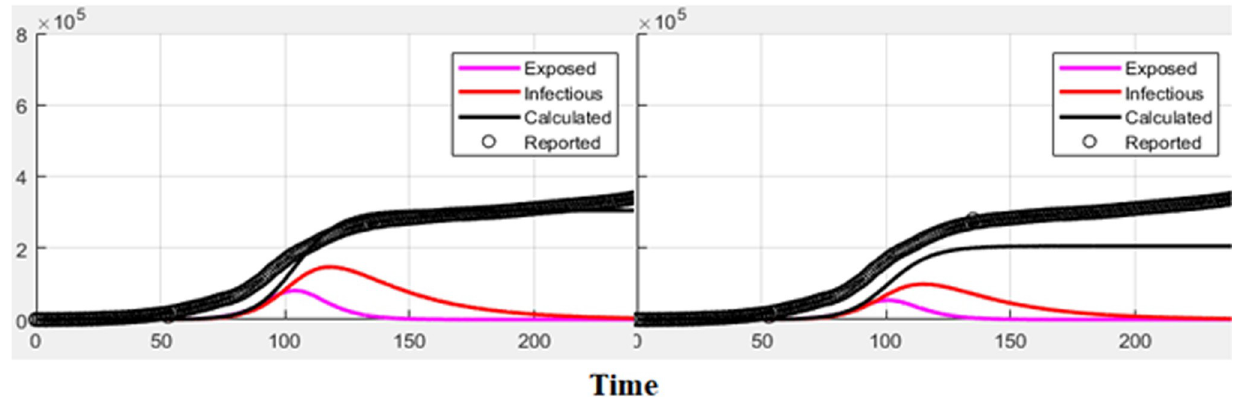
Fig 4. S 0 impact on the results of